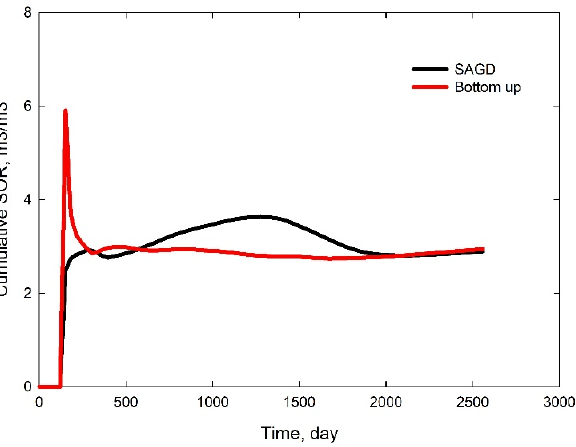
Figure 8. Comparison of cumulative steam oil ratio between SAGD and bottom ‐ up assisted pressure drive processes indicating the bottom ‐ up assisted pressure drive improves the energy efficiency.